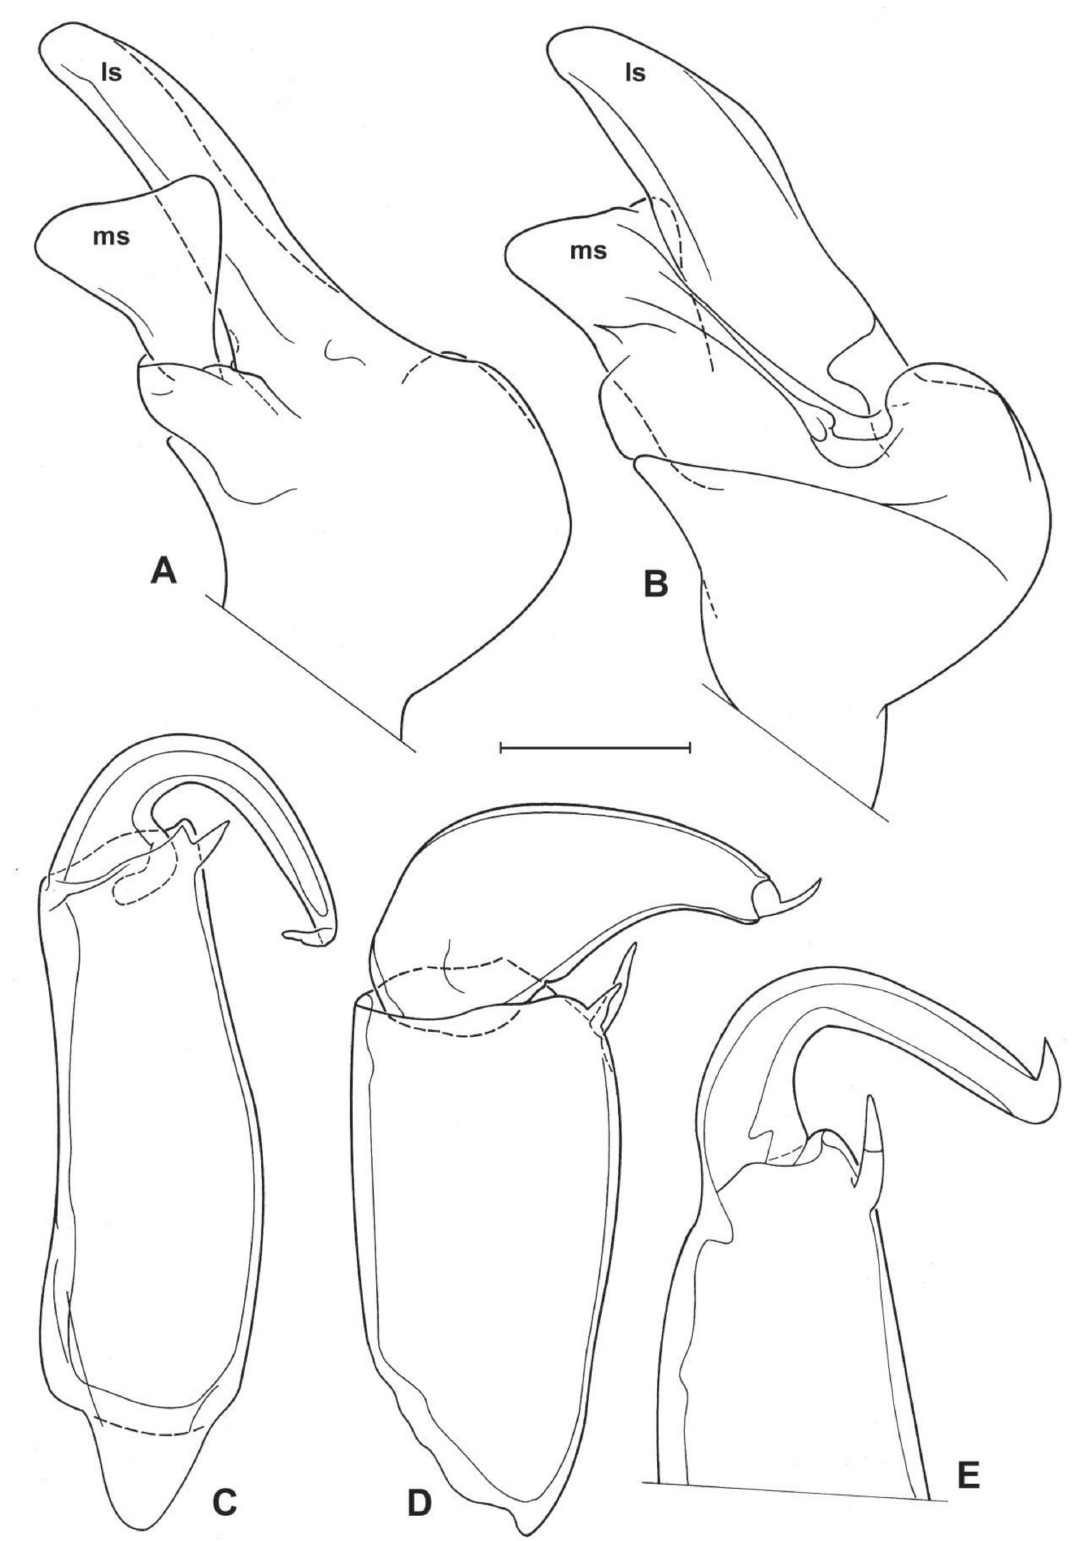
Fig. 10. Bennelongia pinpi De Deckker, 1981. (A-D = W40043 from Pelican Lake QLD, E = W40035 from Lake Louisa QLD). A-B . Outlines of hemipenes. C . Left prehensile palp. D . Right prehensile palp. E . Left prehensile palp. Scales: A-B = 156.3 μm, C-D = 89.3 μm, E = 42.6